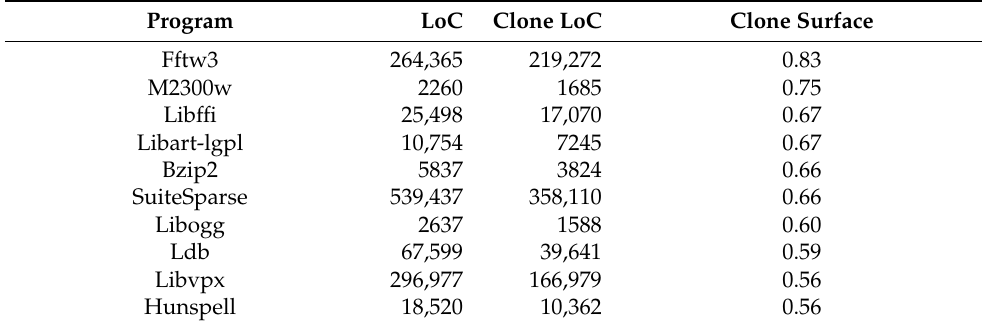
Table 2. Top 10 programs in Ubuntu 18.04 ranked by the clone